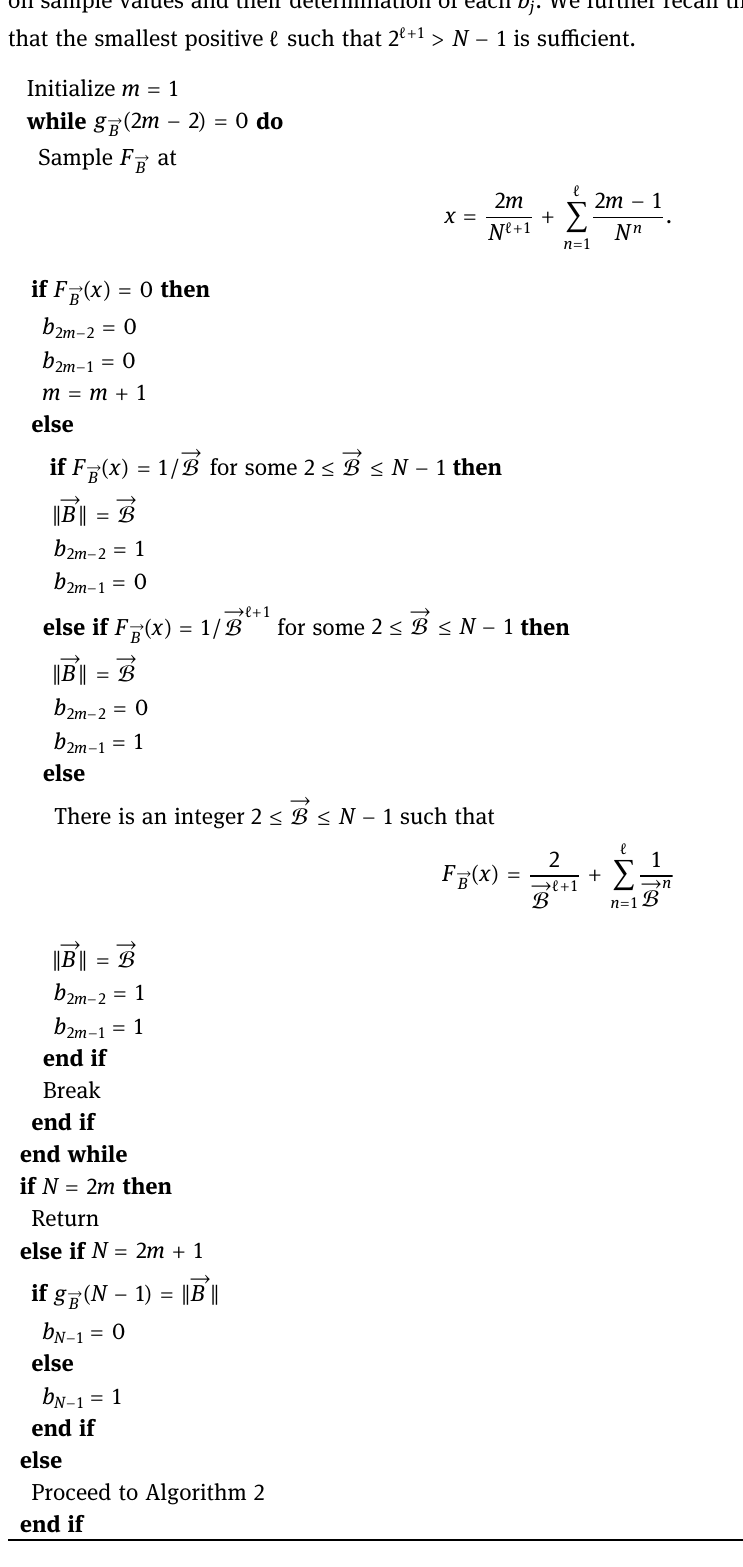
∥→ ∥ B and the fi rst nonzero digit of